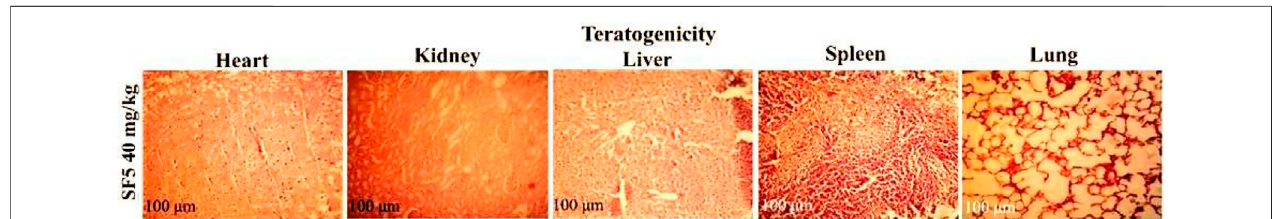
FIGURE 14 | Histopathology of the selected organs in the developmental toxicity study (40 mg/kg).